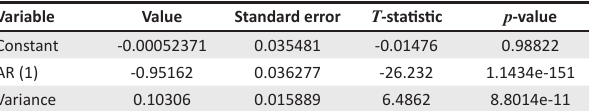
ARIMA (1, 2, 0) Model (Gaussian distribution):